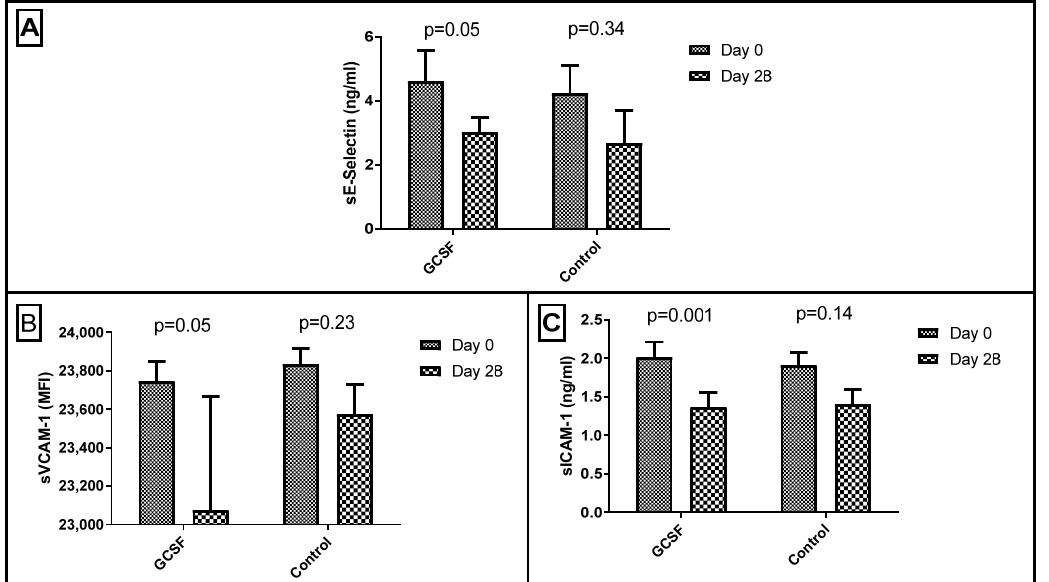
Figure 1. Differences in ( A ) soluble (s) E-Selectin, ( B ) s vascular cell adhesion molecule (VCAM)-1, and ( C ) s intercellular adhesion molecular (ICAM)-1 on 1st and 28th days after limb ischemia induction in the control and granulocyte colony-stimulating factor (GCSF) group.